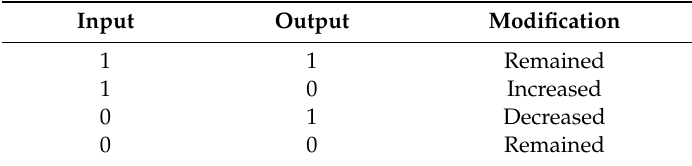
Table 2. Hebbian training method.